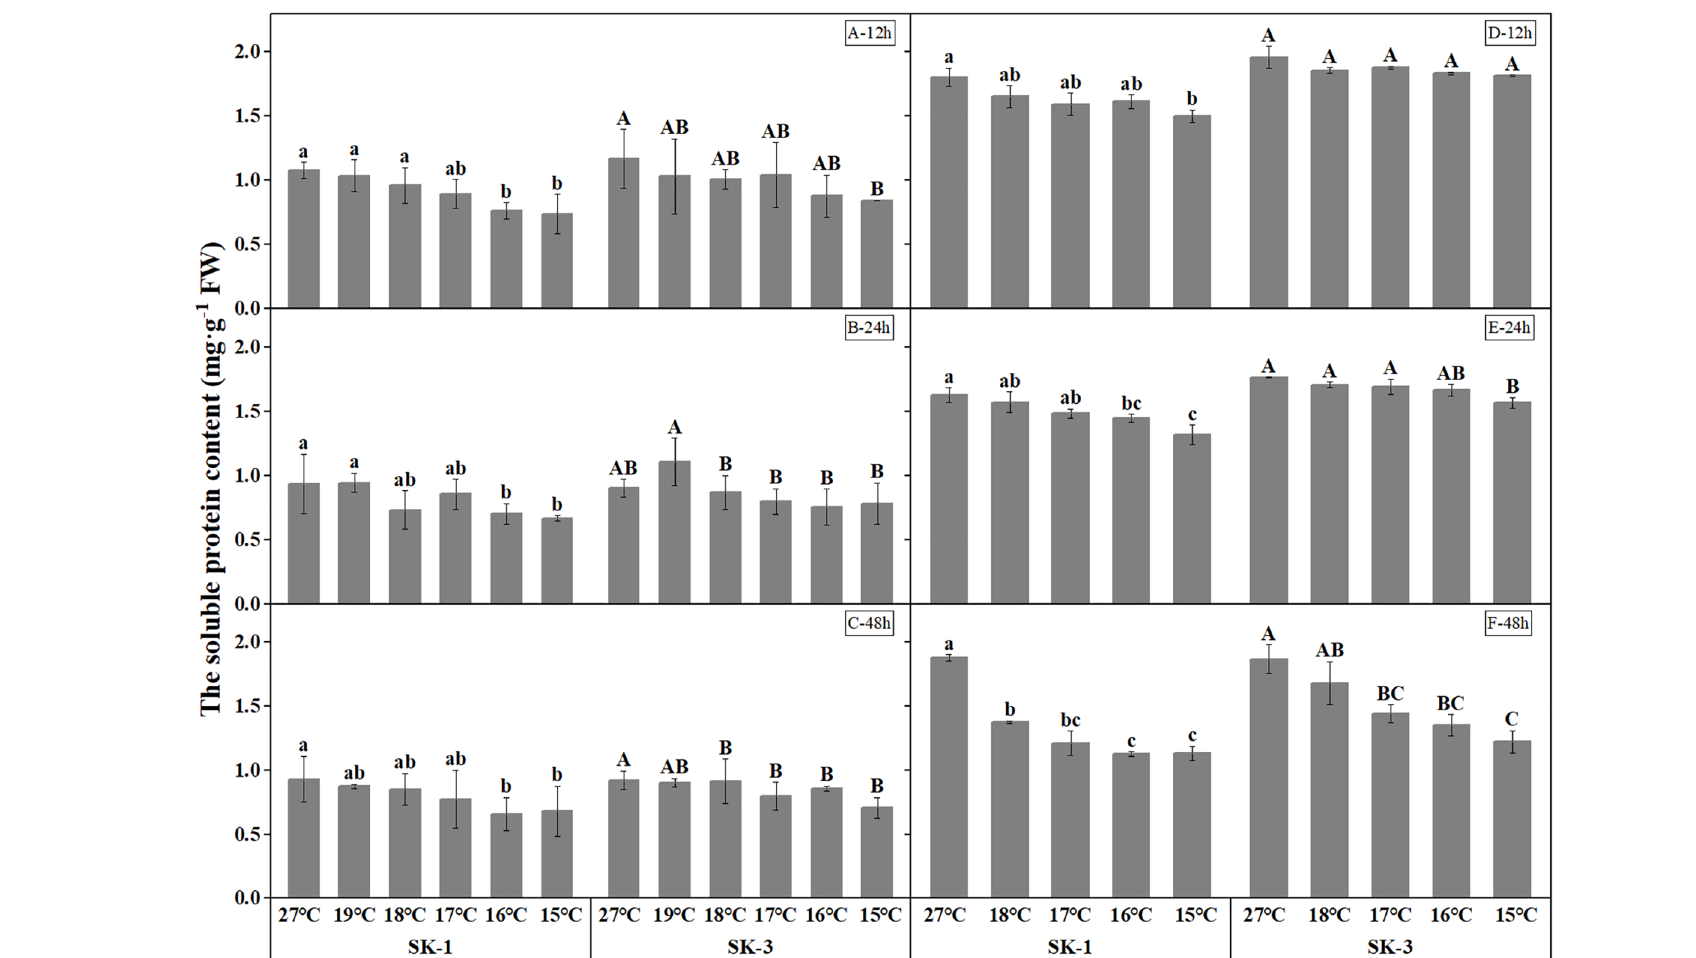
FIGURE 7 Effect of low temperature stress on soluble protein content in cotton squares in 2020 ( A-C : 12h, 24h, 48h stress) and 2021 ( D-F : 12h, 24h, 48h stress). FW represents fresh weight. Different lowercase letters indicate the signi fi cant differences between the treatments of the variety SK1, and different capital letters indicate the signi fi cant differences between the treatments of the variety SK3